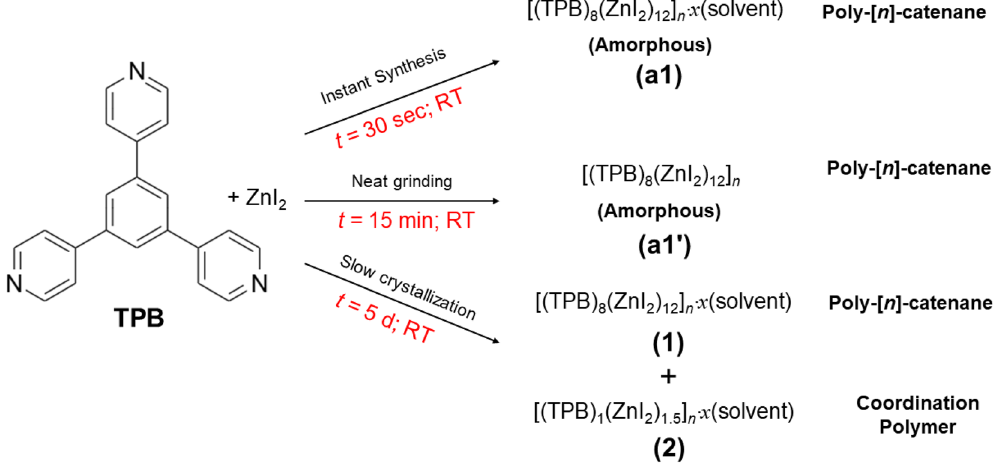
Figure 1. Self-assembly of TPB and ZnI 2 using instant synthesis , neat grinding and slow crystallization approaches at room temperature conditions yielded M 12 L 8 poly-[ n ]-catenane ( a1 , a1 ′ and 1 ) and coordination polymer ( 2